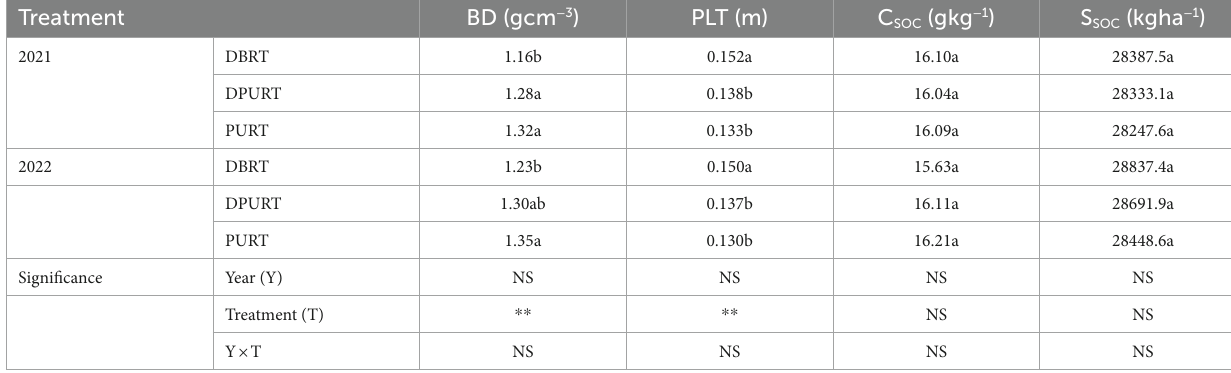
TABLE 5 BD, T, C SOC , and S SOC of soil in the three tillage treatments in 2021 and 2022.